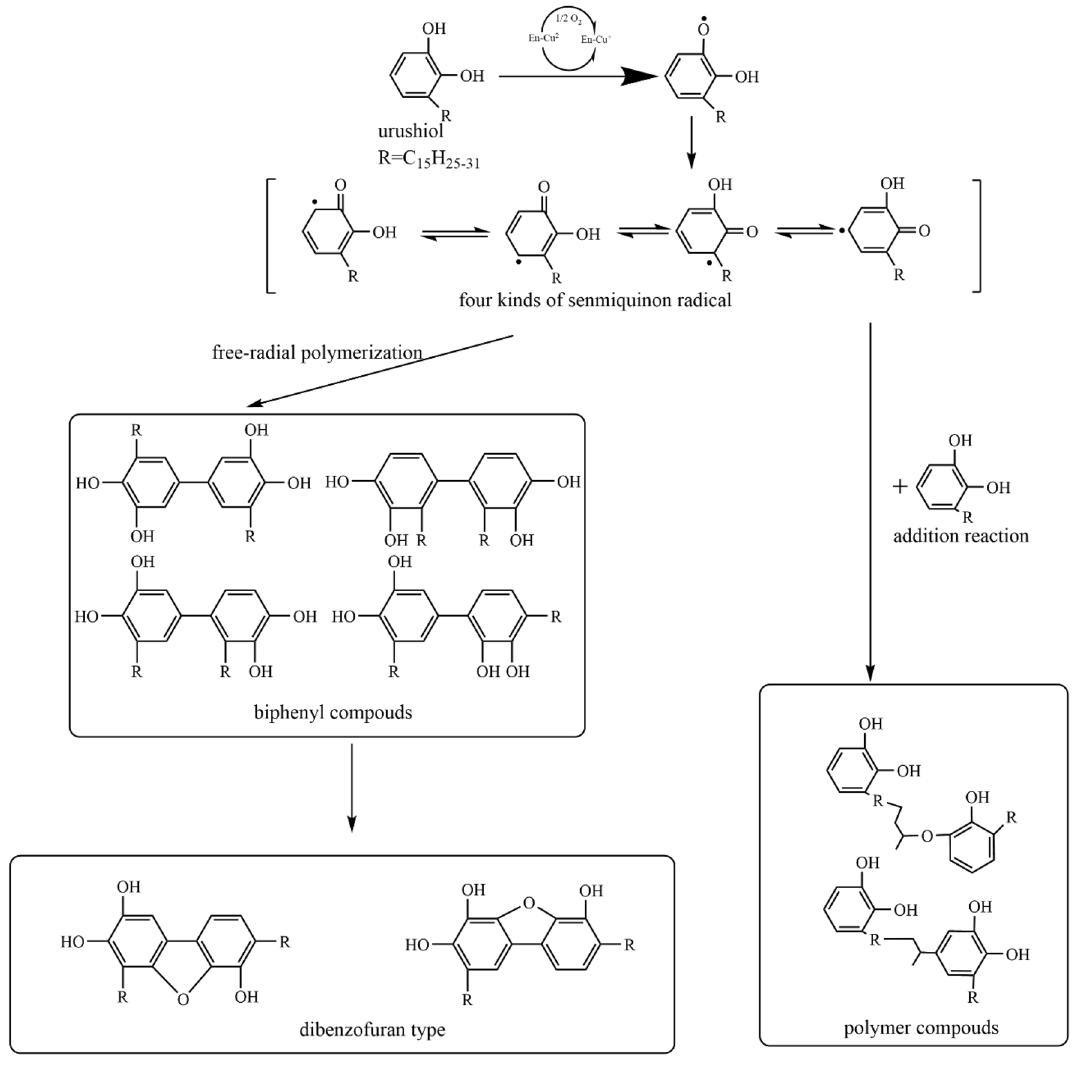
Figure 1. Oxidation mechanism of urushiol catalyzed by